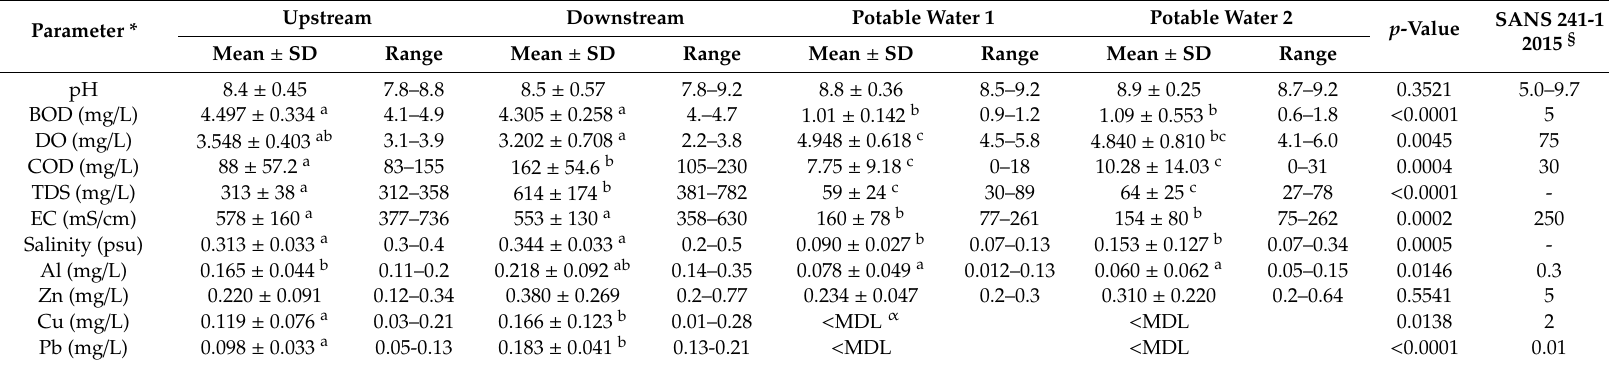
Table 5. Physicochemical characteristics and mean concentrations of major heavy metals (mg / L) in Vaal River samples upstream and downstream of WWTP e ffl uent discharge and potable water around the Vaal